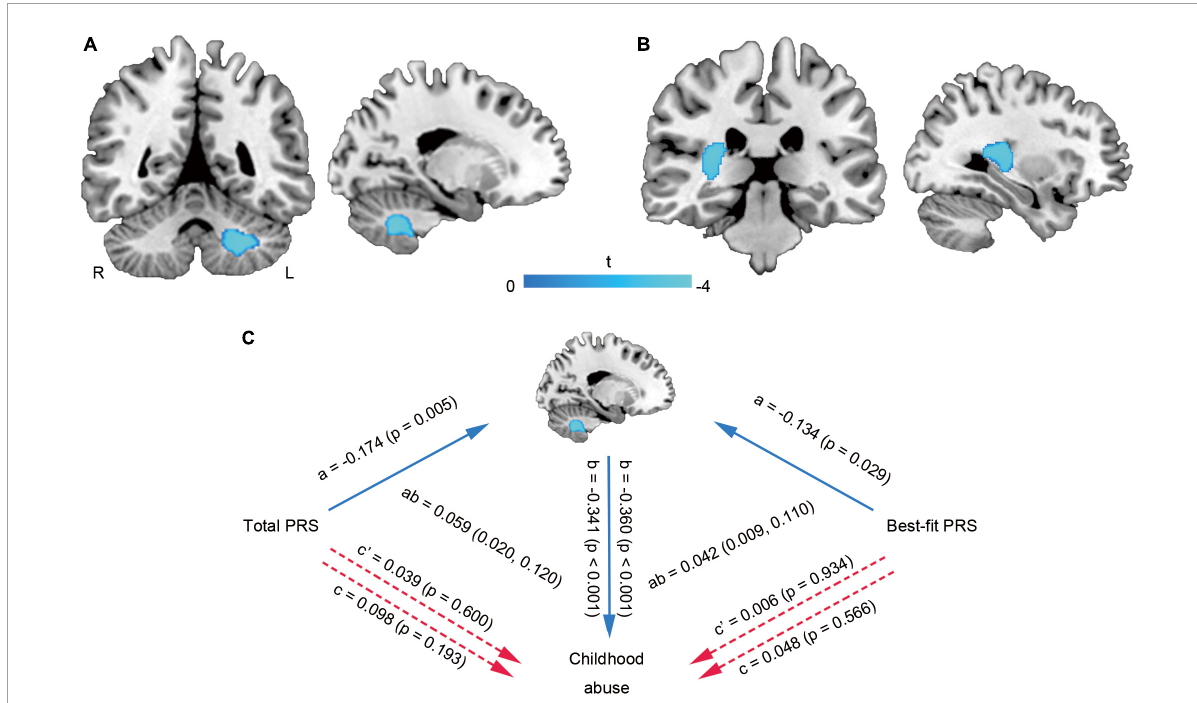
FIGURE3 Brain white matter alterations related to childhood abuse and mediation analysis. The WMVs of left cerebellum cluster (A) and right temporal lobe-basal ganglia region (B) were negatively correlated with the total abuse score. The cerebellar WMV-change mediated the effects of PRS on childhood abuse score (C) . L, left; PRS, polygenic risk score; R, right; WMV, white matter volume.